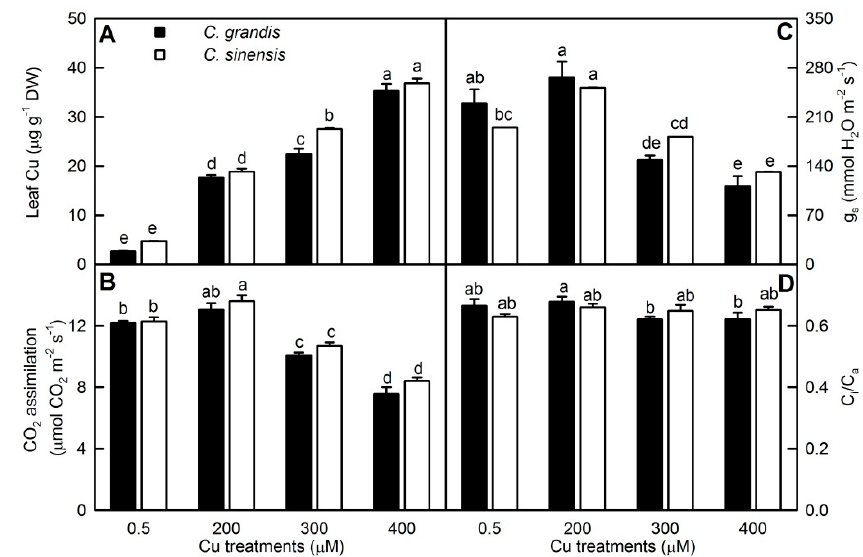
Figure 1. Cu-effects on Cu concentration ( A ), CO 2 assimilation ( B ), stomatal conductance (g s , C ) and ratio of intercellular to ambient CO 2 concentration (C i /C a , D ) in Citrus grandis and Citrus sinensis leaves. Bars represent means ± SE ( n = 8 except for 4 for leaf Cu). Different letters above the bars indicate significant differences at p < 0.05.